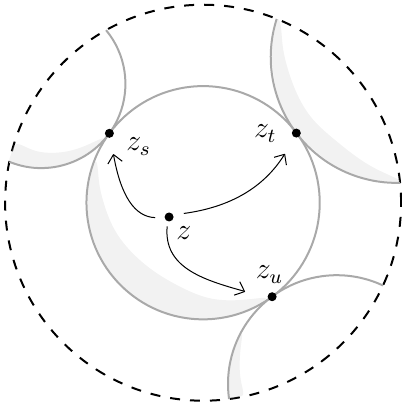
Figure 2 . Neighborhood of the three degenerations related by BCJ